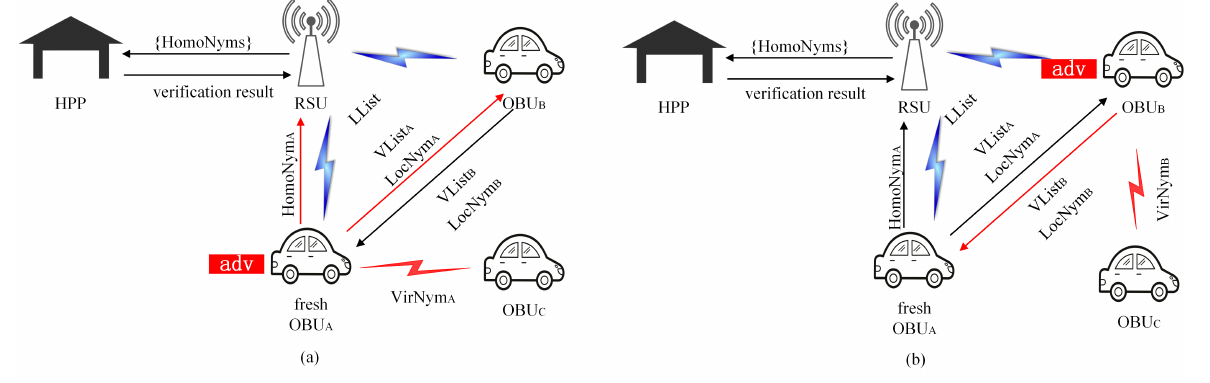
Figure 5. Attack model. The attacker in ( a ) is a fresh OBU A that joins VANETs. The attacker in ( b ) is the existing OBU B in